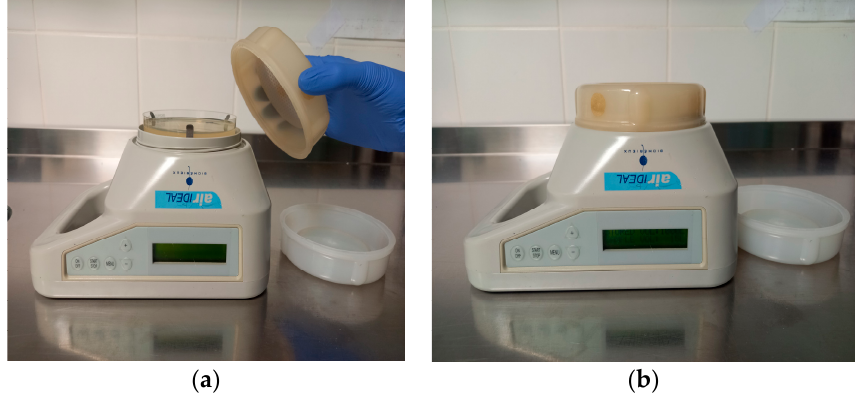
Figure 2. Air sampling with portable air sampler. ( a ) Preparing of air sampler for sampling procedure. Petri dish with Sabouraud medium is placed and covered with sterile sample grid. Time of duration and volume of air to be sampled is defined and visible on display. ( b ) Air sampling in process. Air containing spores is aspirated and inoculated through a sampling grid onto growth medium.